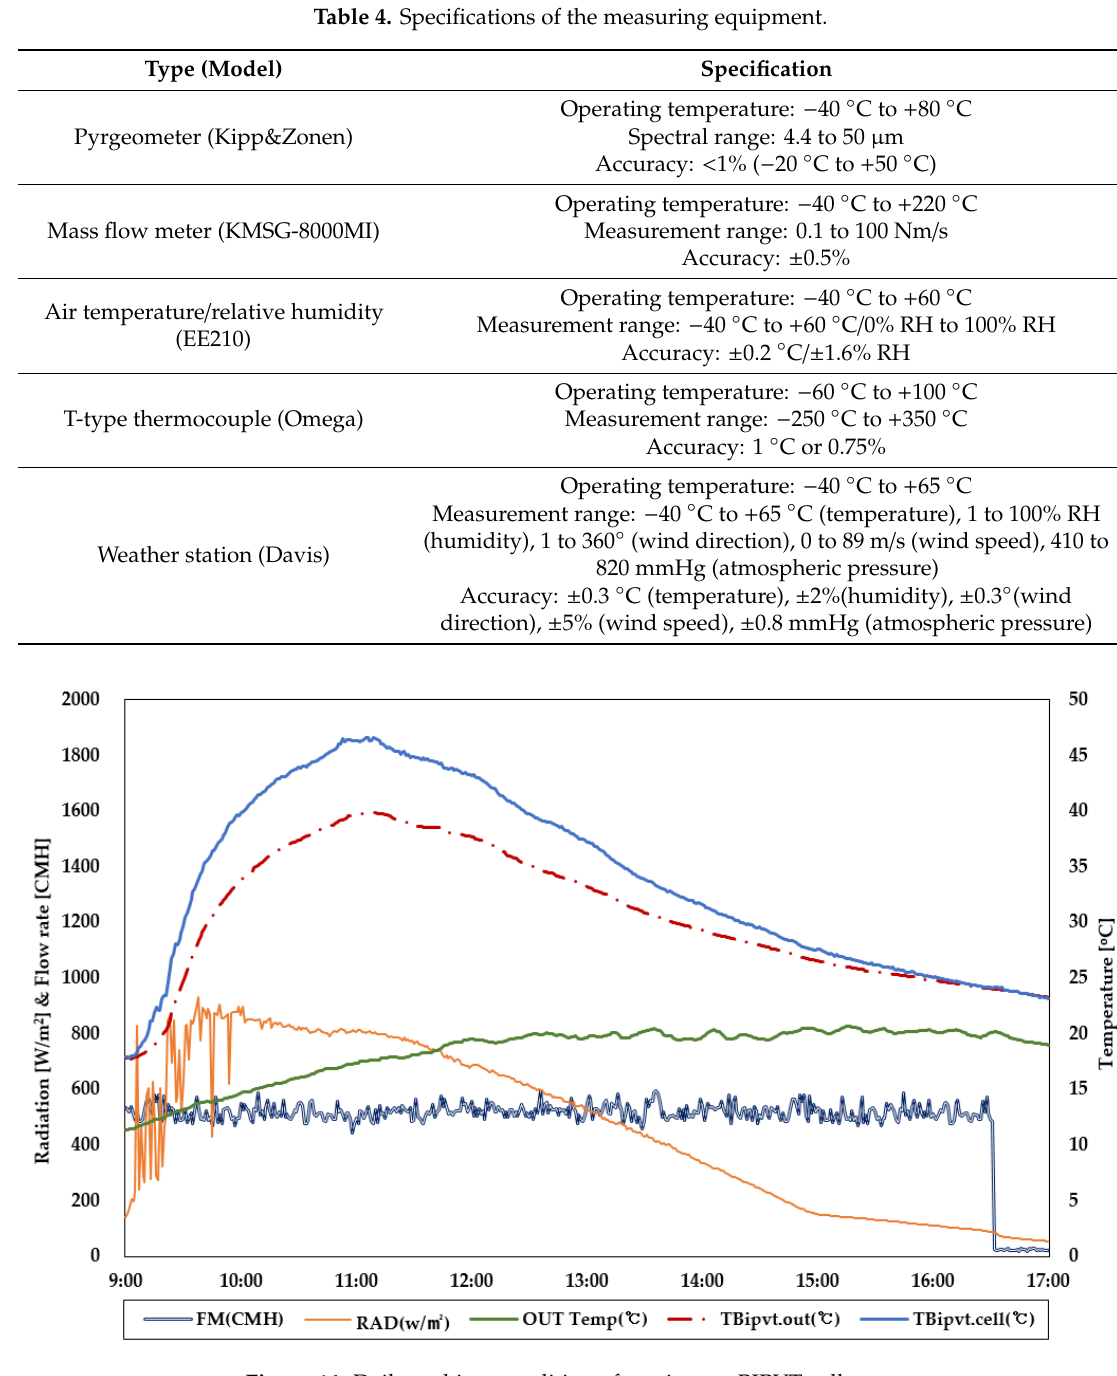
Figure 15. Temperature characteristics according to solar radiation.